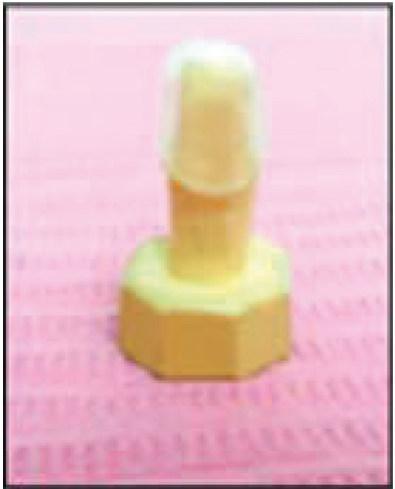
Figure 7: Coping former.